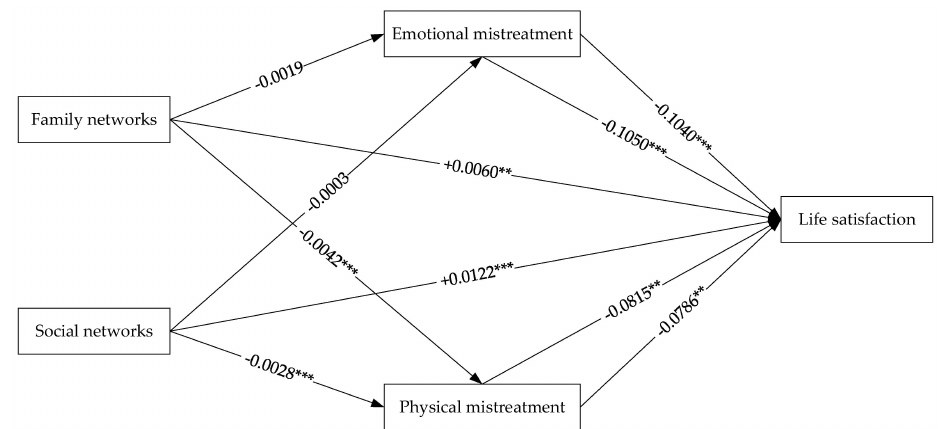
Figure 2. Path analysis results; the numbers are the unstandardized regression coefficients obtained from the ordinary least squares; ** 5% significance, *** 1%